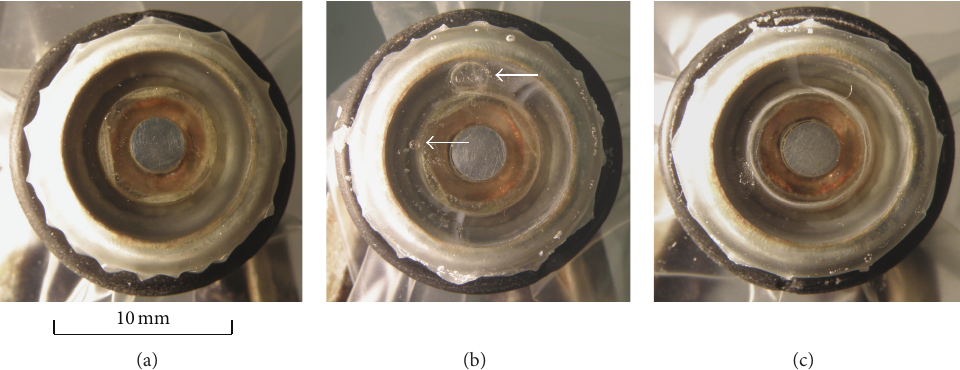
Figure 6: States of the closed oxygen sensor before and after four cycles of warming-up/cooling (gas bubbles are indicated by arrows): (a) initial state, (b) after the use of medium saturated with atmospheric air, (c) after the use of medium depleted of dissolved gases. A view of the sensor with the cathode side is shown. For 4-cycle heating/cooling in all cases (b, c) there is negligible corrosion of the zinc anode and the appearance of salt deposits on the inner side of the membrane. If the heating takes place in medium saturated with atmospheric oxygen (b), the changes are more pronounced and in addition the formation of gas bubbles is observed. When heating is carried out in the medium depleted of dissolved gases (c), after the experiment, condition of the sensor does not differ from the initial (a).